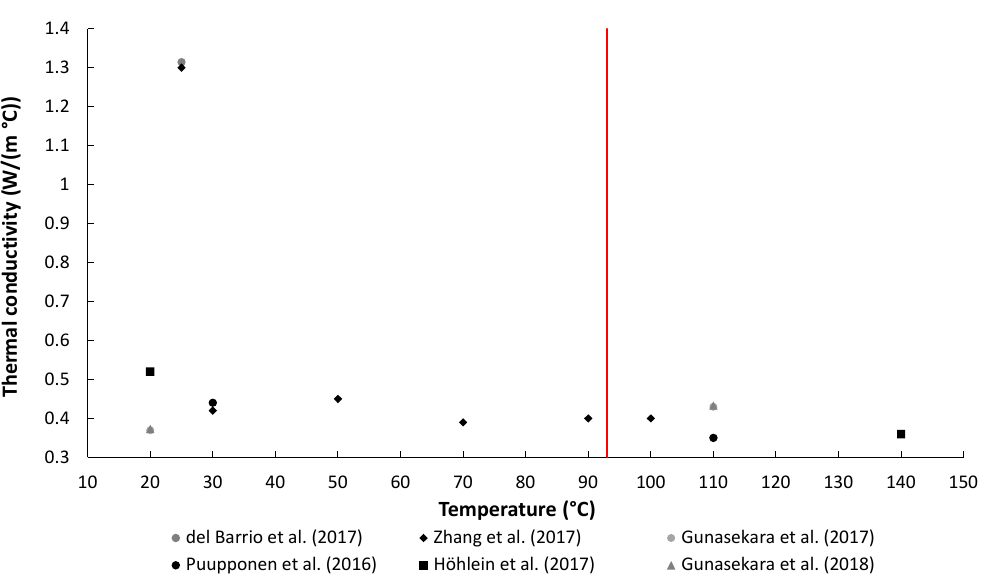
Figure 2. Xylitol specific heat collected from the literature as a function of temperature. The red vertical line indicates the melting temperature and delimits the solid phase ( left ) from the liq- uid phase ( right ). The points from the work of Zhang et al. [26] at 80 °C and 90 °C refer to the supercooled liquid.